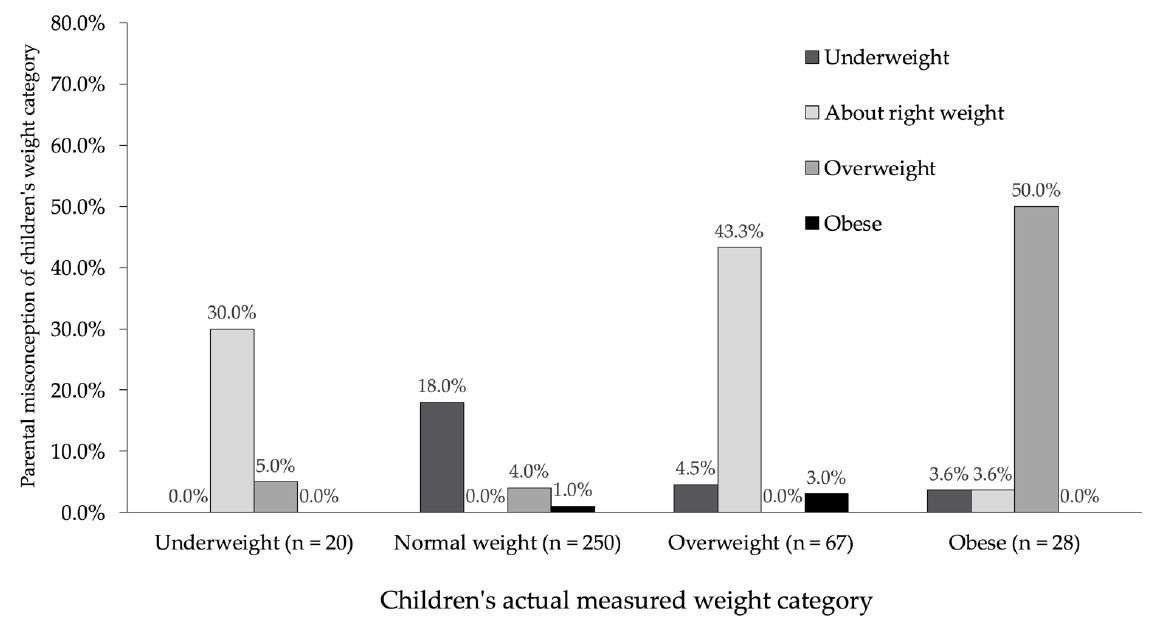
Figure 1. Parents’ misclassification rate by measured weight categories. For instance, 18% of normal-weight children were perceived as underweight.